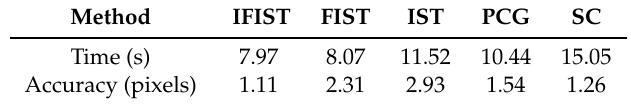
Table 2. Comparison of different methods.